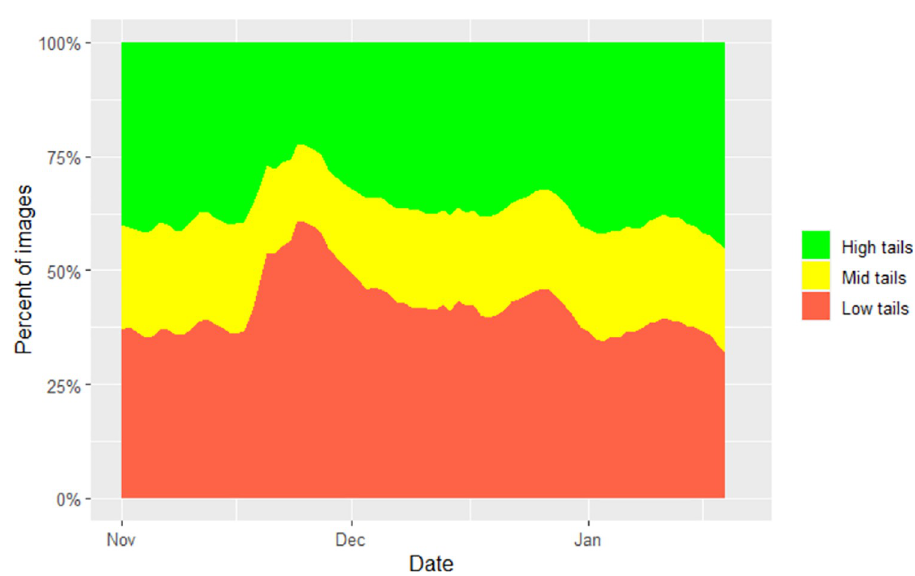
Fig 8. Example of tail posture data for a batch in which tail injury disrupted tail posture-stacked bar graph of proportion of low (red), mid (yellow) and high (green) tails by day.